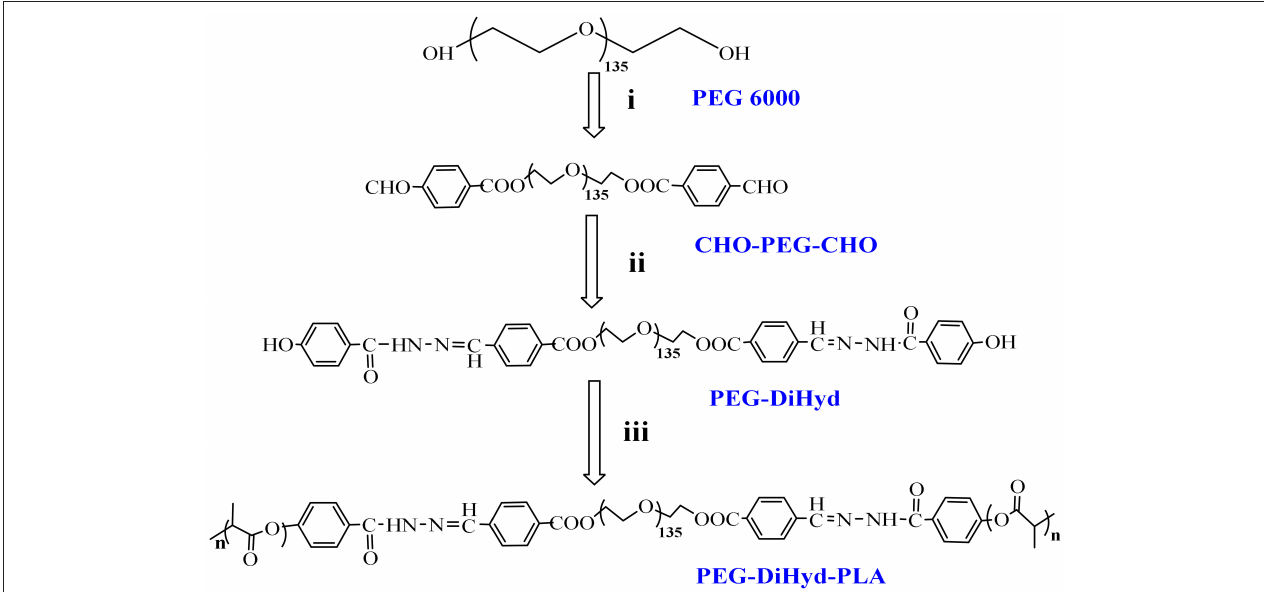
FIGURE 2 | Synthesis route of copolymers PEG-DiHyd-PLA. (i) 4-Formylbenzoic acid, DCC, DMAP,R.T.; (ii) (4-Hydroxybenzoyl) hydrazine, Methanol, DMF, 68 ◦ C; (iii) Lactide, Sn(oct) 2 , Toluene,110 ◦ C, N 2 .